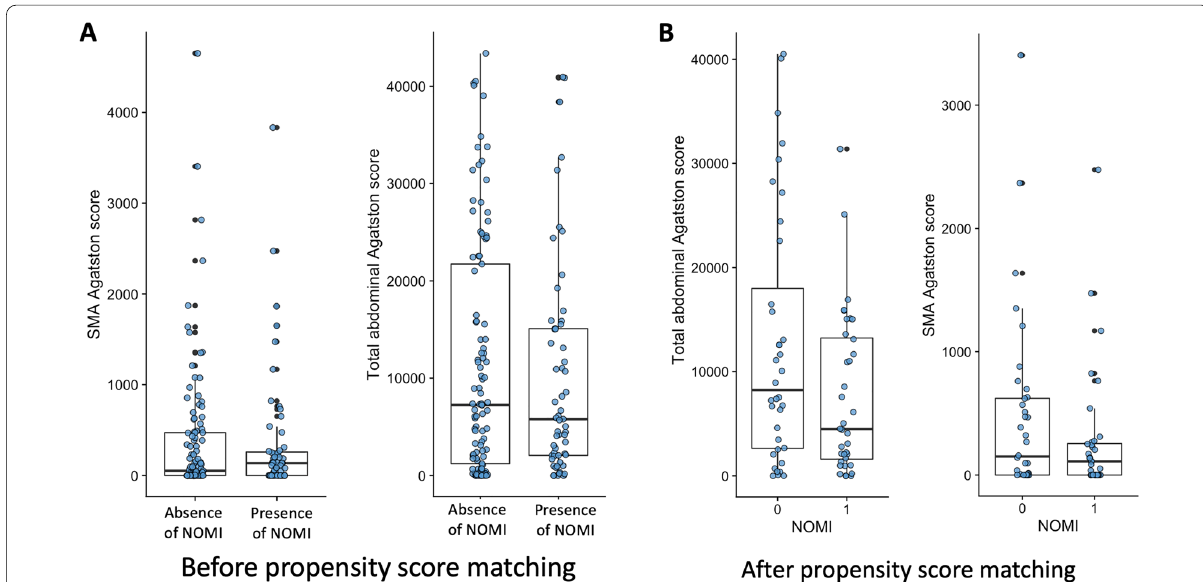
Fig. 3 Boxplots of the distribution (median and interquartile range) of superior mesenteric artery and total abdominal calcium score according to nonocclusive mesenteric ischemia. Lines are median and interquartile range. A Before propensity score matching analysis. B After propensity score matching analysis. SMA Superior mesenteric